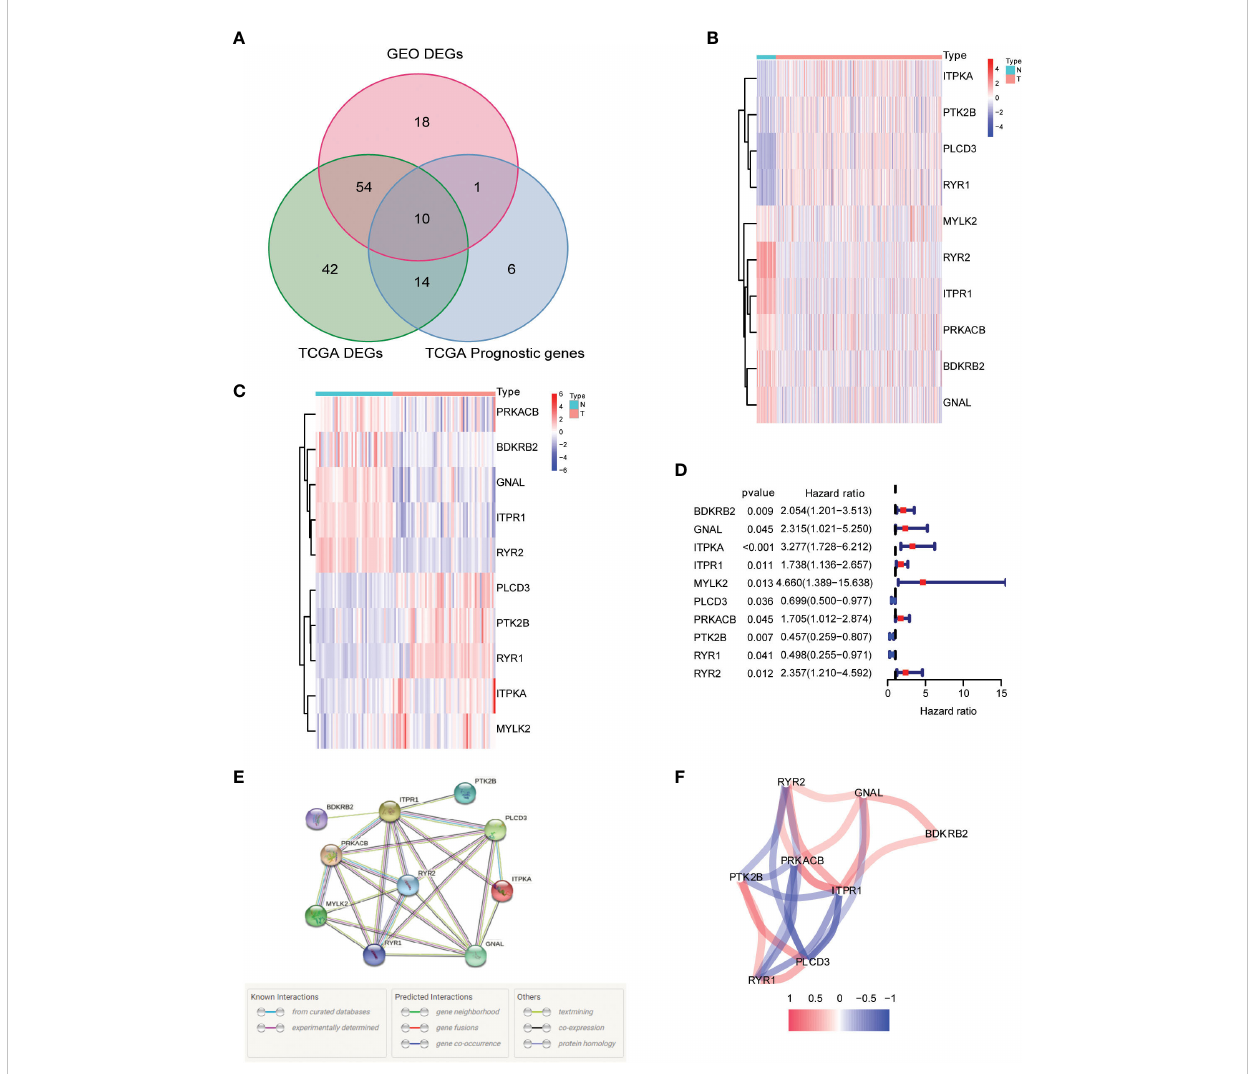
FIGURE 2 Identi fi cation of calcium metabolism related differentially expressed genes. (A) Venn plot of the differentially expressed genes between tumor and normal tissue that were correlated with OS. (B, C) Heatmaps of the differentially expressed genes associated with OS. (D) Forest plot of the results of the univariate Cox regression analysis between gene expression and OS. (E, F) The correlation of the differentially expressed genes associated with